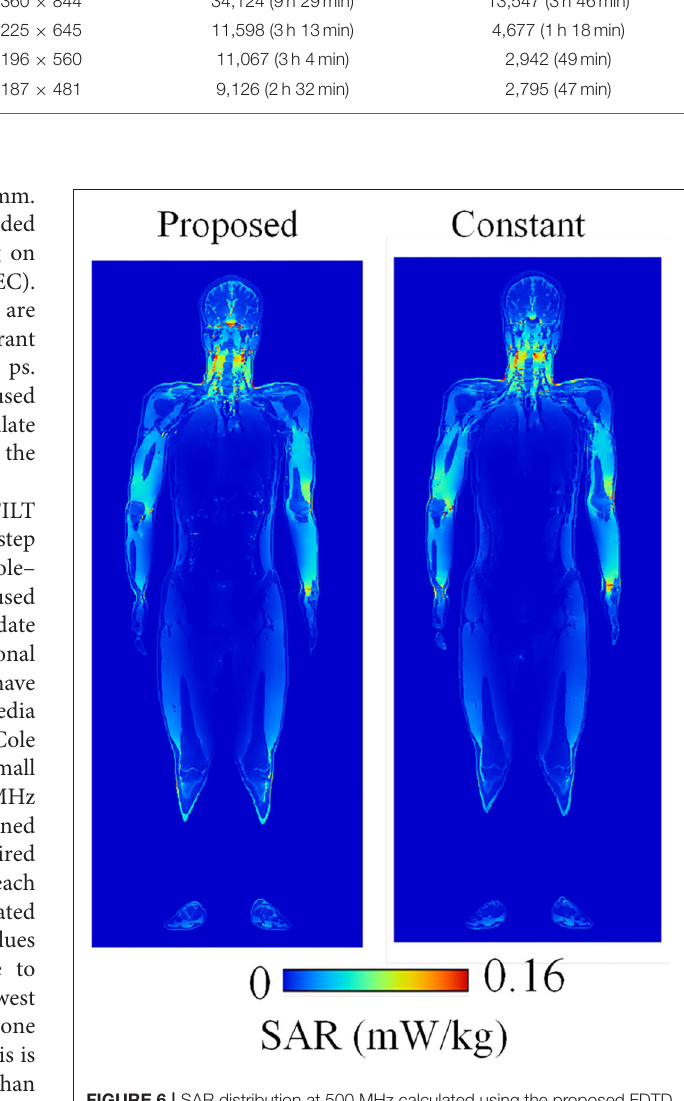
FIGURE 6 | SAR distribution at 500 MHz calculated using the proposed FDTD method and that using the conventional FDTD method with constant dielectric